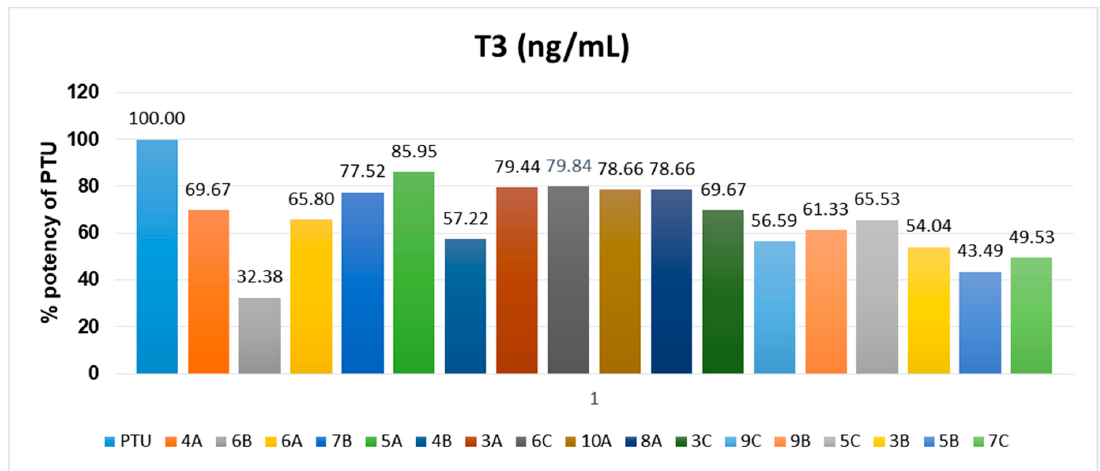
Figure 3. Potency of antithyroid derivatives compared to 6- n- propyl-2-thiouracil (PTU).